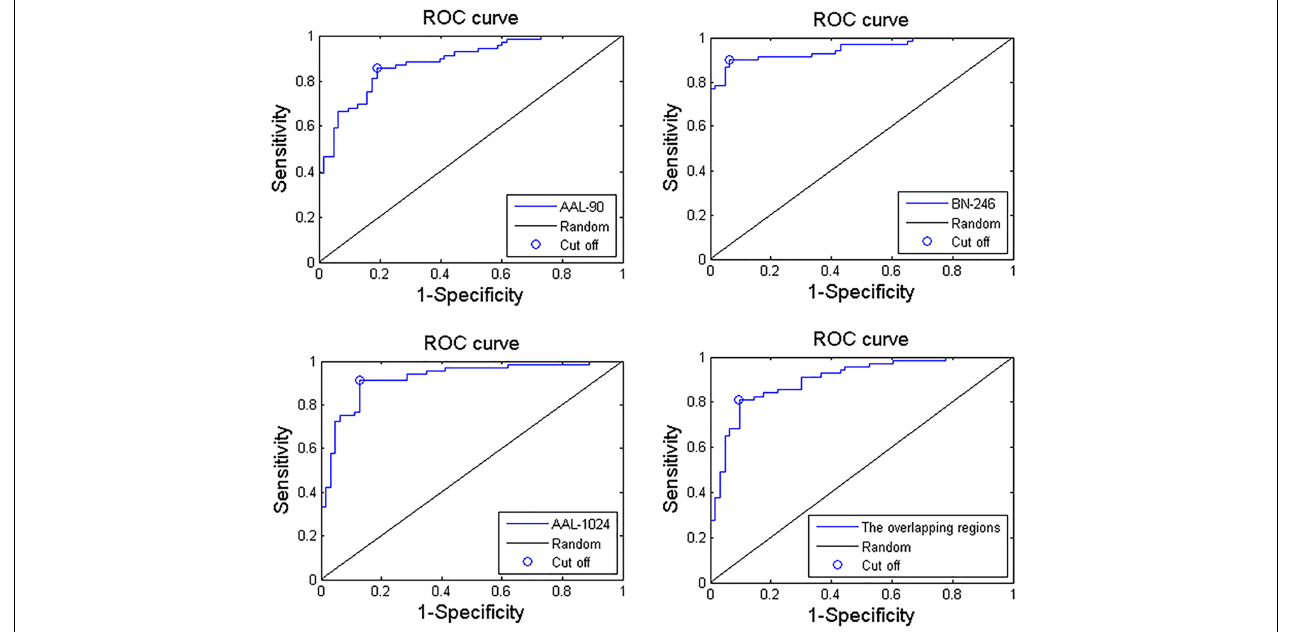
FIGURE 5 | Three ROC curves of the proposed MCI identification method with AAL-90, BN-246, AAL-1024 atlas, and the overlapping abnormal regions, respectively.